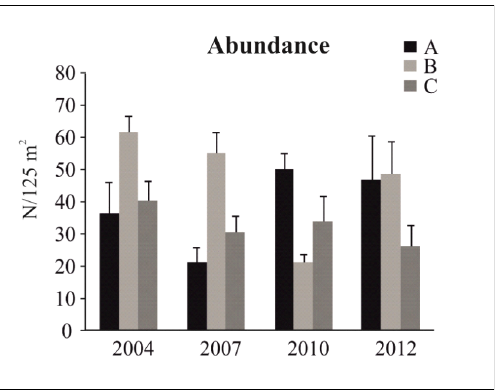
Fig 5. Zonation effect on commercial species. Mean values ( ± SE) of